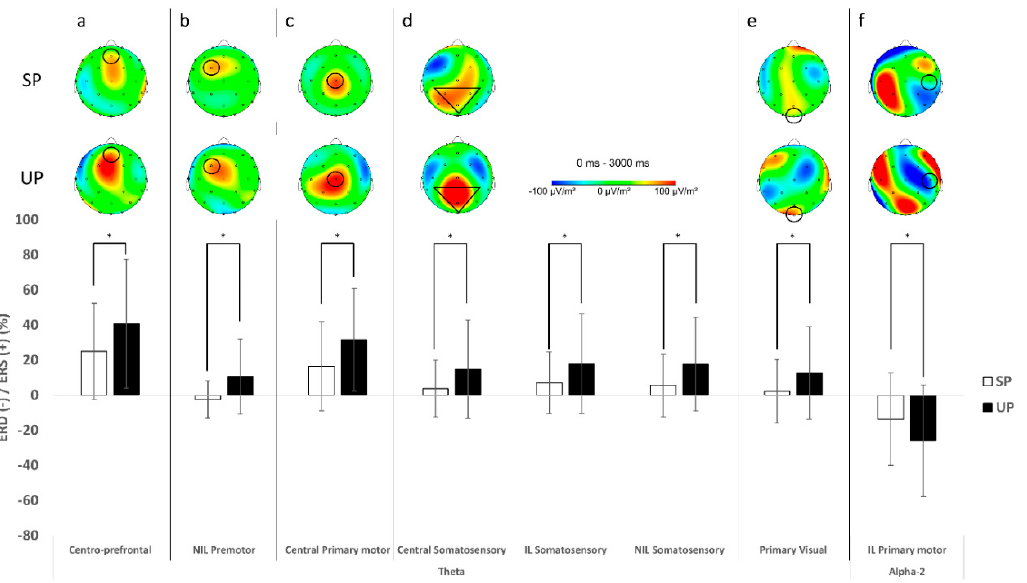
tion, UP: unstable condition, IL: contralateral cortical region associated with the stance limb, NIL: